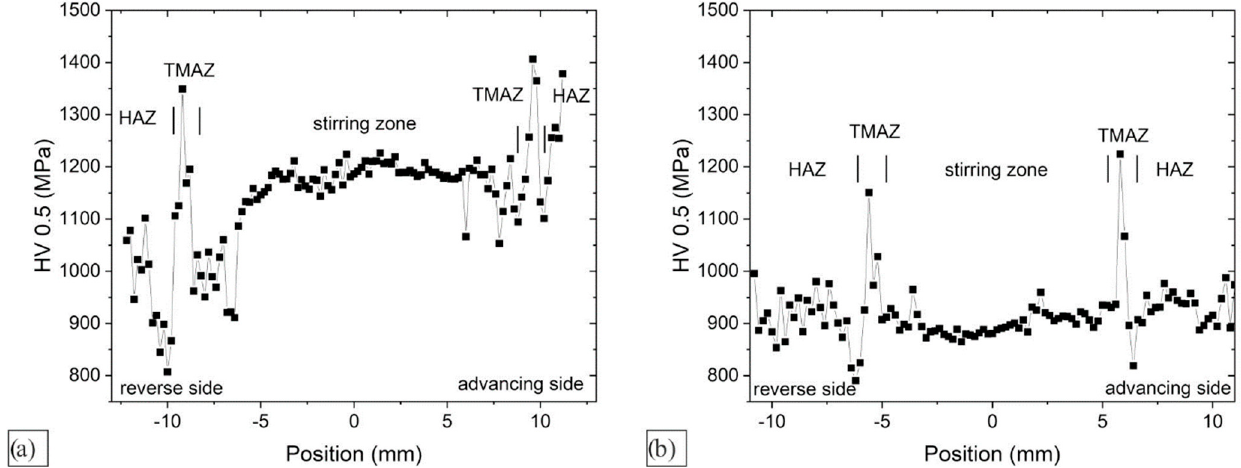
Figure 4. Variation of Vickers indentation hardness 700 μ m below the surface for rotational speeds of ( a ) sample FSP95 and ( b ) sample FSP950.